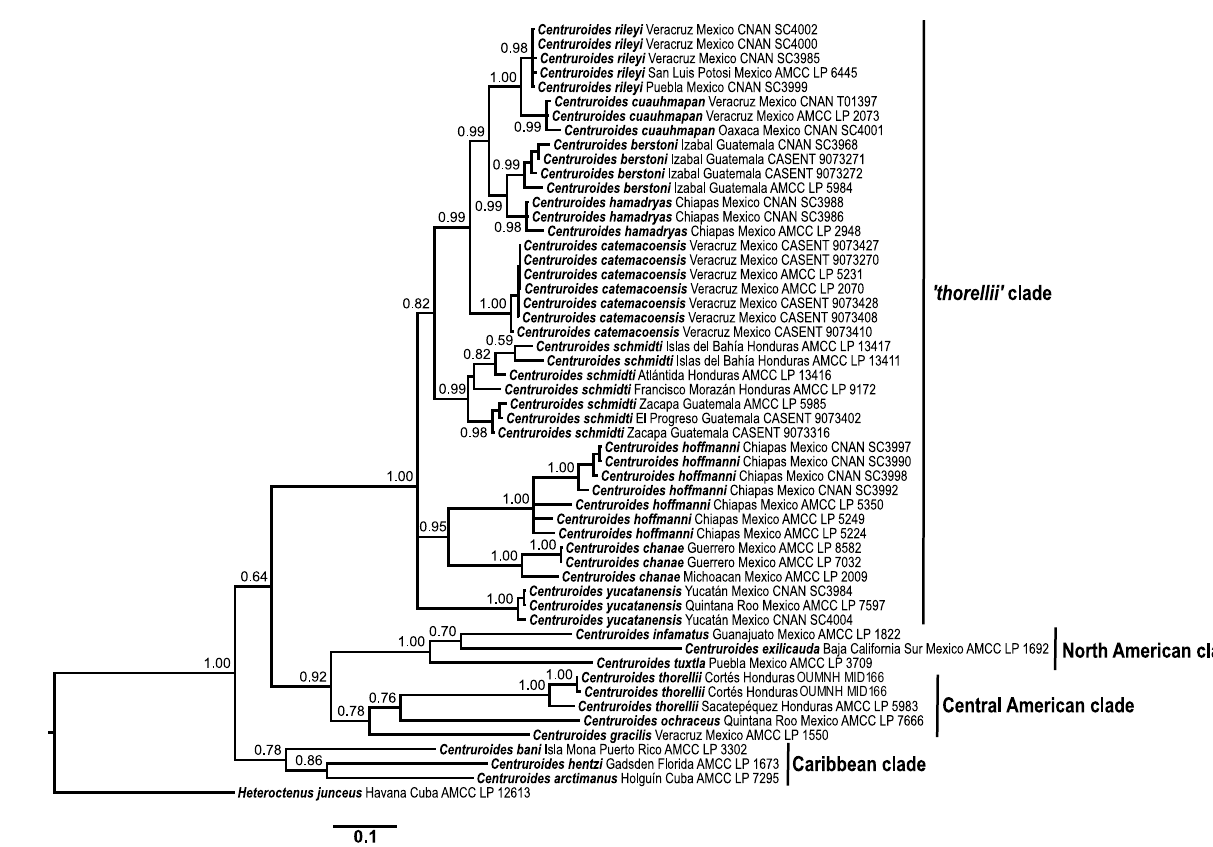
Figure 3. Phylogeny of the arboreal Neotropical ‘ thorellii ’ clade of Centruroides Marx, 1890 bark scorpions (Buthidae C.L. Koch 1837) based on Bayesian analysis of 112 morphological characters and 1078 base pairs of DNA sequence from the mitochondrial Cytochrome c Oxidase Subunit I gene for 53 specimens of the ingroup with outgroup species of Centruroides and Heteroctenus junceus (Herbst, 1800). Material was deposited in the following collections: Ambrose Monell Cryo Collection (AMCC) at the American Museum of Natural History, New York; Colección Nacional de Arácnidos, Instituto de Biología (CNAN), Universidad Nacional Autónoma de Mexico, Mexico City; California Academy of Sciences (CASENT), San Francisco; Oxford University Museum of Natural History (OUMNH), UK.